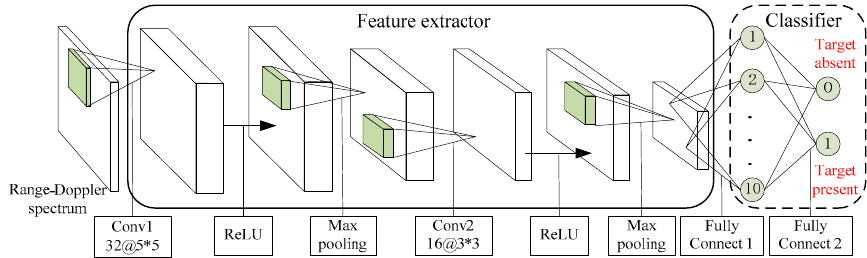
Figure 12. Structure of a CNN detector for RTD with Range ‐ Doppler spectrum.